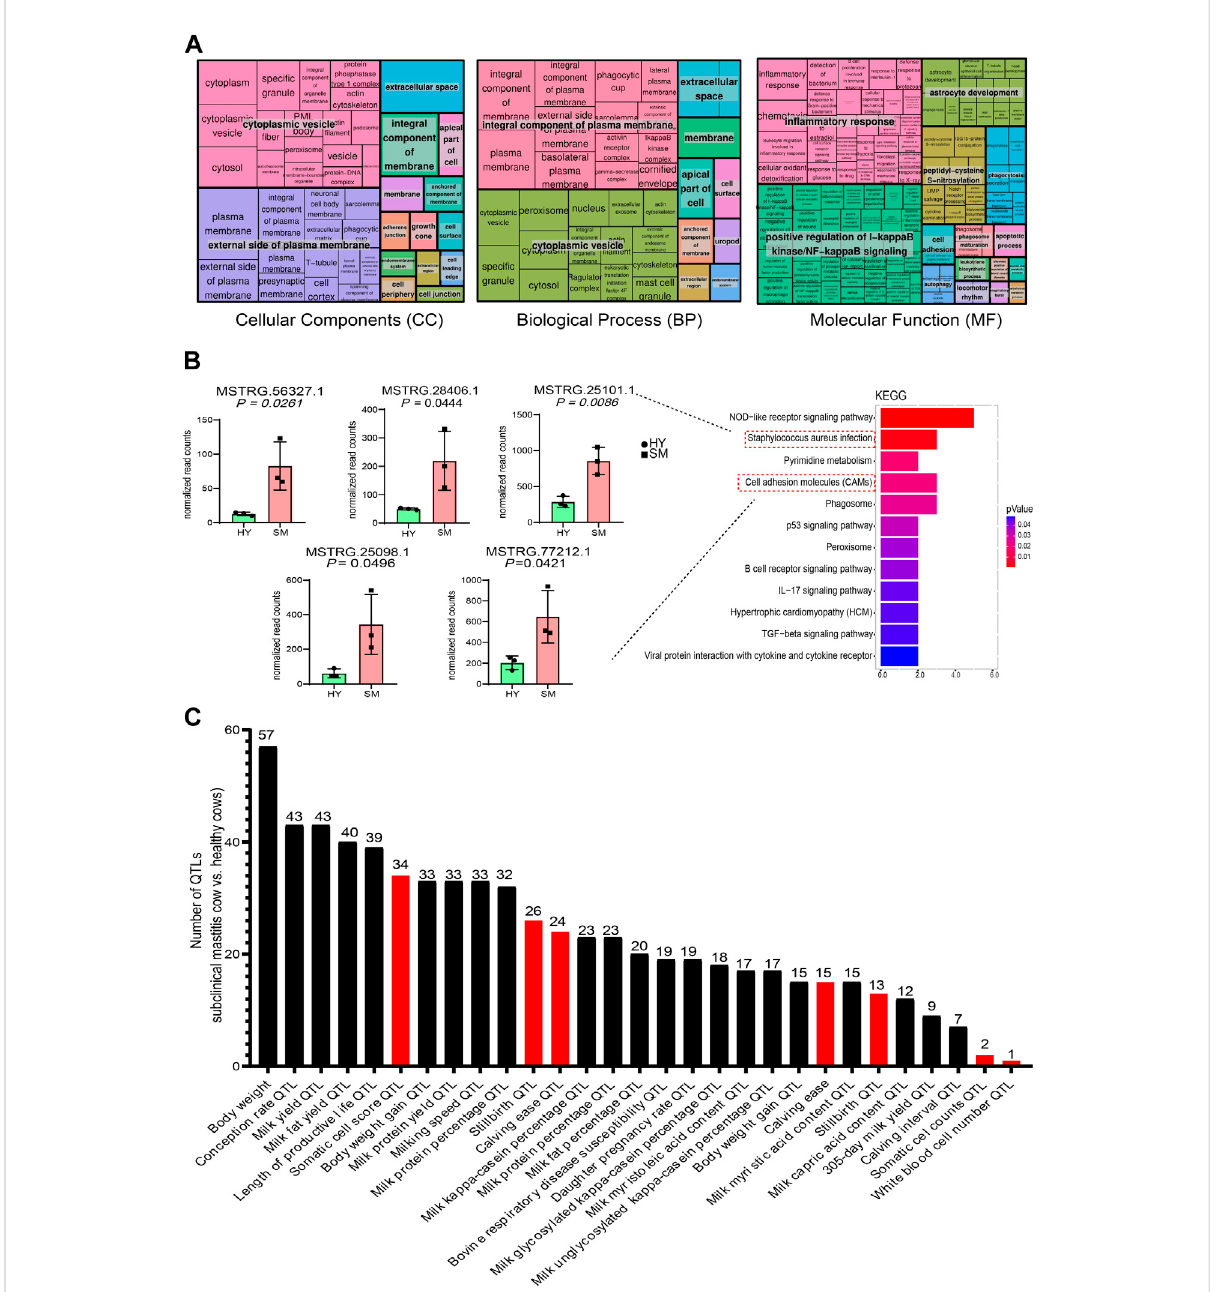
FIGURE 5 Results of GO and KEGG analysis of lncRNAs cis -and trans -target genes. (A) Signi fi cant GO terms ( p -value < 0.05) for cis - and trans- target genes of lncRNAs, including 197 GO terms for biological processes (BP), 44 GO terms for cellular components (CC) and 55 GO terms for molecular functions (MF). (B) Signi fi cant KEGG pathways for cis and trans target genes of lncRNAs ( p -value < 0.05), and expression differences of the differentially expressed genes (DEGs) involved in the enrichment of the NOD-like receptor signaling, S. aureus infection, and cell adhesion pathways. (C) Annotation results of DELs in subclinical mastitis cows compared to healthy cows, with red bars showing DELs associated with reproductive traits and